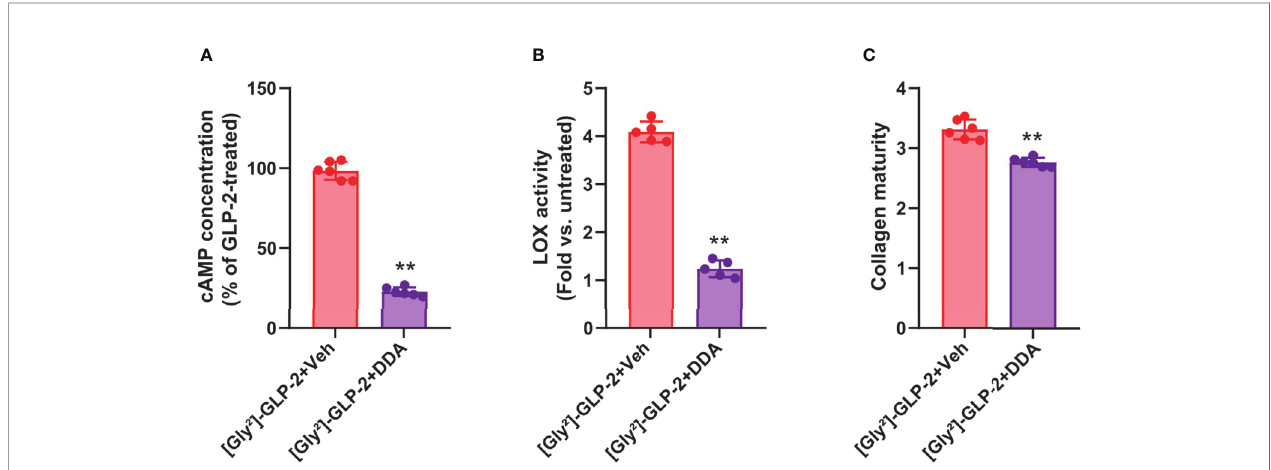
FIGURE 3 | GLP-2 action on collagen maturity is dependent on adenylyl cyclase activity. MC3T3-E1 osteoblast cells were incubated with a speci fi c adenylyl cyclase inhibitor (DDA) prior to incubation with 50 pM [Gly²]-GLP-2. (A) cAMP, (B) LOX activity, and (C) collagen maturity in osteoblast cultures. ** p < 0.01 vs . vehicle-treated